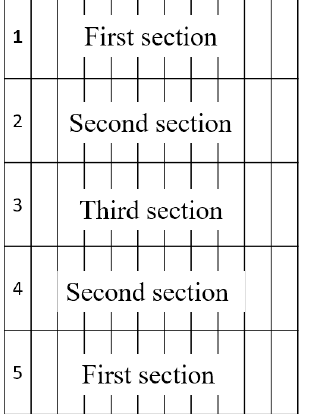
Figure 2. Waste incineration bed segmentation.